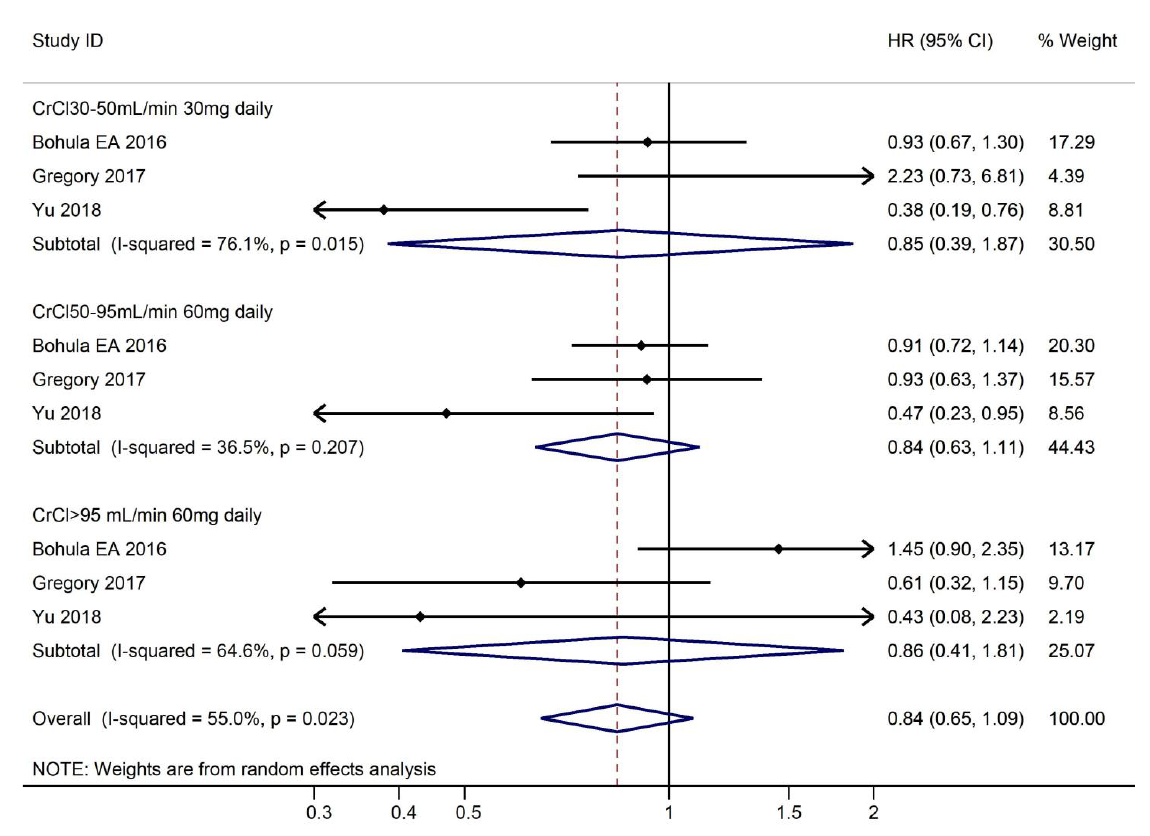
Figure 6. Risk of ischemic stroke and use of edoxaban versus warfarin in relation to CrCl. Generally, no difference was observed in mortality reduction between edoxaban and